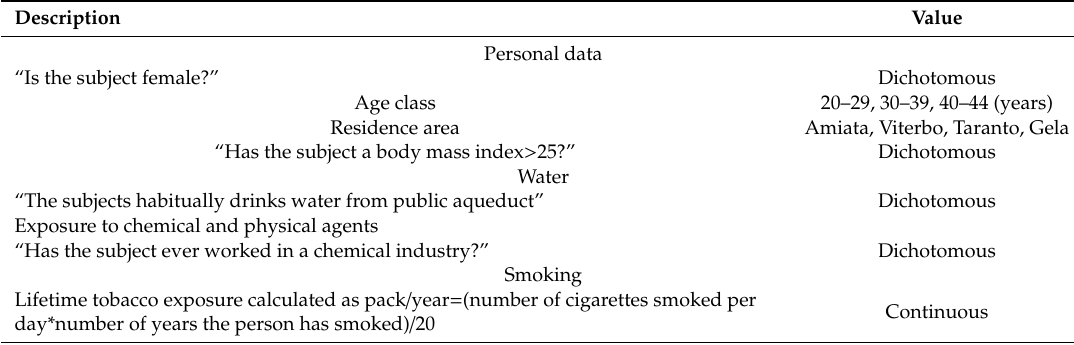
Table 2. Questionnaire variables selected for the statistical